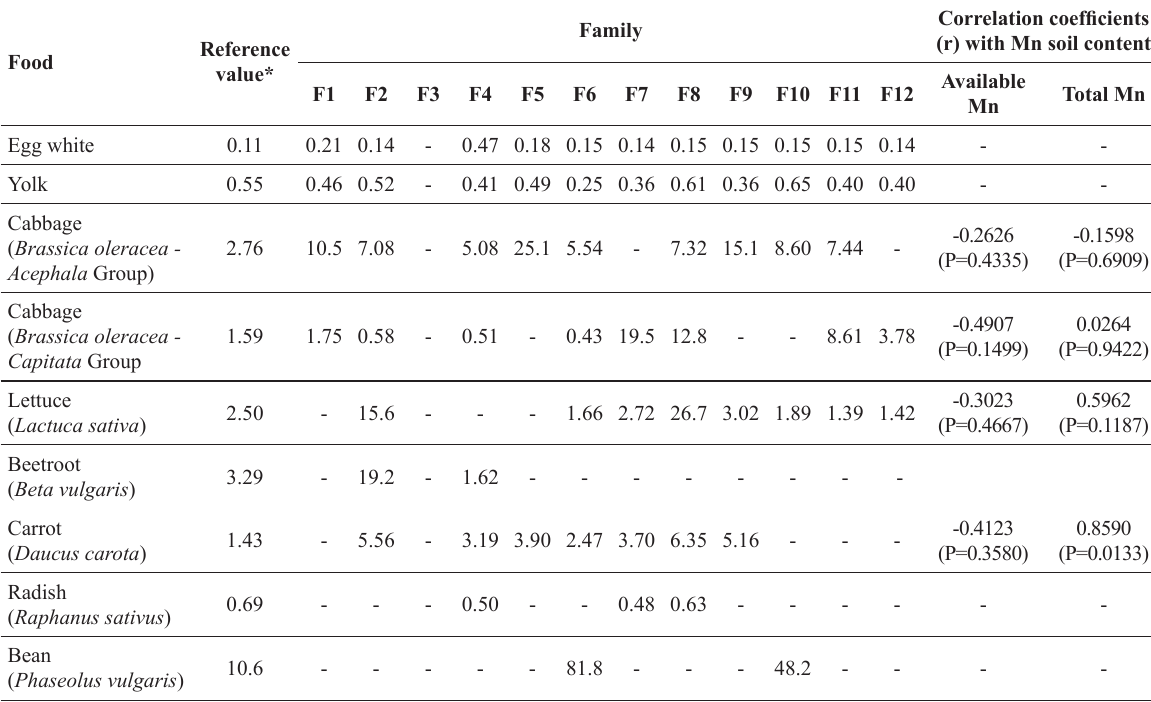
Mn content in foods collected in selected families’